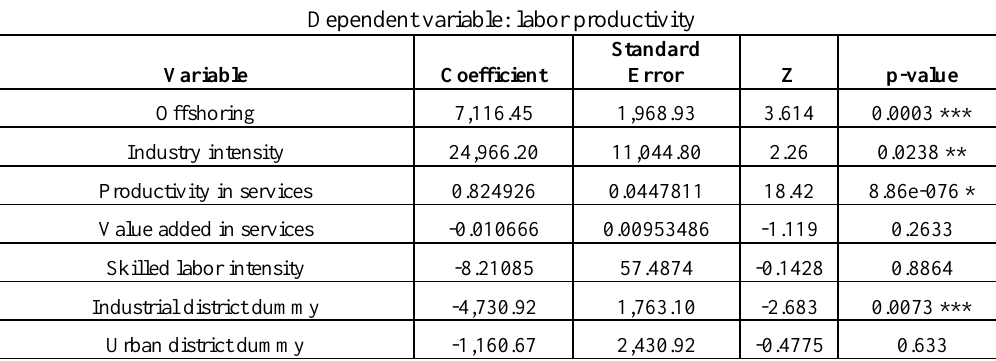
Table 6: Explaining Labor Productivity in Italian Provinces 1999-2010 Dependent variable: labor productivity Variable Coefficient